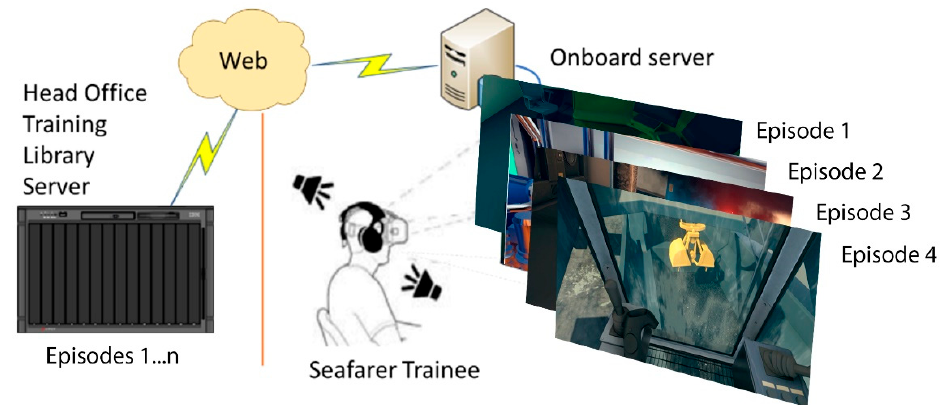
Figure 7. Immersive Safe Oceans Technology’s training library